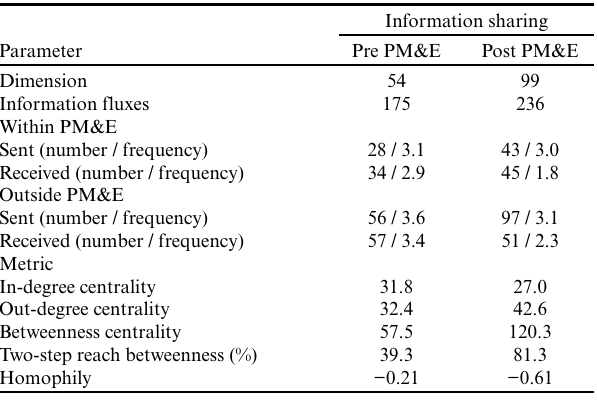
Table 5. Comparison of egocentric social network parameters on information sharing generated from individual farmer interviews pre and post (after three years) involvement in participatory monitoring and evaluation